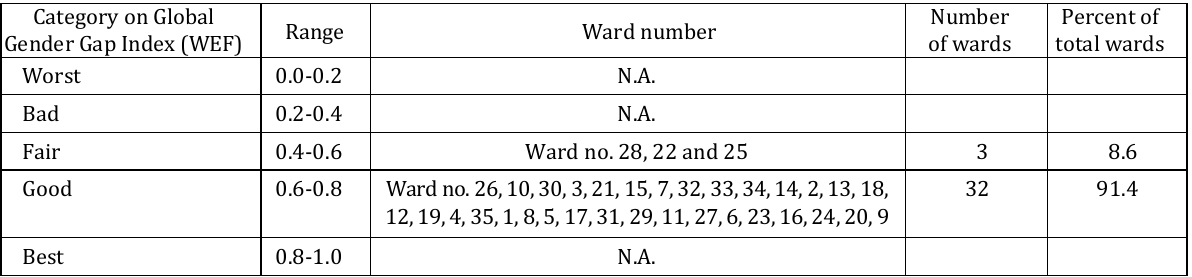
Table 3. Categories on Global Gender Gap Index of the World Economic Forum and Gender Gap Index for Sehore M.C. Category on